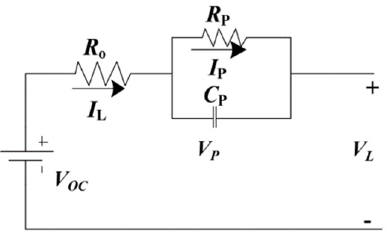
( b ) Figure 5. Test results of the trained ANN with 5 , 000 random samples: ( a ) error of the estimated SOC, and ( b ) estimated and actual SOCs.